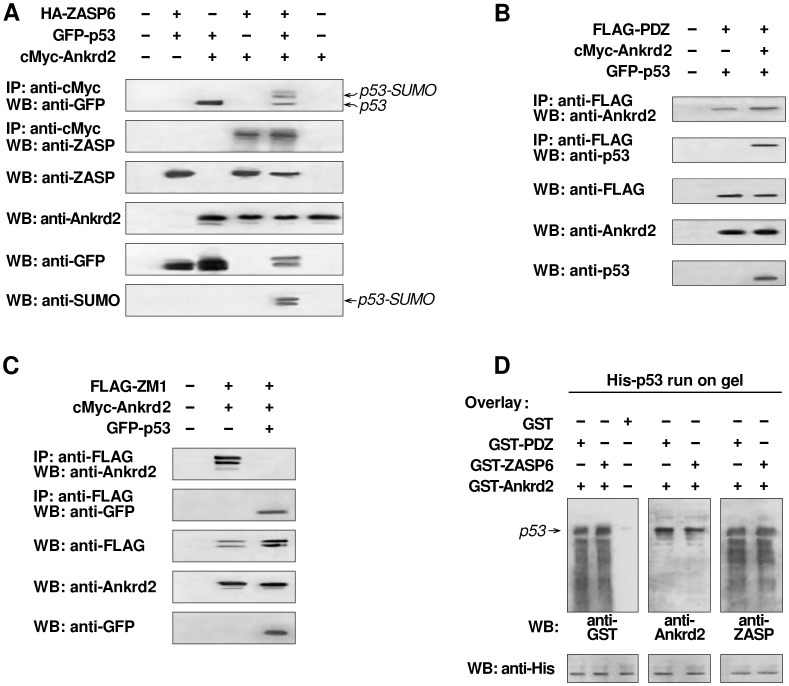
ZASP6, Ankrd2 and p53 are able to form a triple complex.(A) H1299 cells (p53−/−) were transfected with pcDNA3-HA-ZASP6, pcDNA3-p53 and pCMV3B-Ankrd2 as indicated. Transfected cell lysates were used for immunoprecipitation with anti-cMyc antibody. The top two panels represent the immuno-complexes separated by SDS-PAGE and blotted either with anti-GFP conjugated with HRP or anti-ZASP antibodies. Third, fourth and fifth panels represent Western blots of the extracts of transfected cells probed with anti-ZASP, anti-Ankrd2 and anti-GFP antibodies. The membrane where p53 was detected with anti-GFP antibody was stripped and reprobed with a mixture of anti SUMO-1 and anti-SUMO-2/3 antibodies (bottom panel). B) Co-IPs performed using lysates from H1299 cells transfected with pCMV2B-PDZ, pCMV3B-Ankrd2 and pEGFP-p53 as indicated. After immunoprecipitation with an anti-FLAG monoclonal antibody, SDS-PAGE and blotting, the membranes were probed with anti-Ankrd2 (first panel) or anti-p53 (second panel) antibodies. As controls, cell lysates were probed with anti-FLAG, anti-Ankrd2 and anti-p53 antibodies (respectively, third, fourth and fifth panels). C)
In vivo interaction between ZM1, Ankrd2 and p53 was tested by co-immunoprecipitation of Ankrd2 and p53 with immunoprecipitated FLAG-ZM1 from lysates of the transfected H1299 cells using anti-FLAG antibody. Immuno-complexes were separated by SDS-PAGE, blotted and then probed with anti-Ankrd2 (first panel) and anti-GFP antibody conjugated with HPR (second panel). Expression levels of tested proteins were evaluated by Western blot, with anti-FLAG, anti-Ankrd2 and anti-GFP antibodies (respectively, third, fourth and fifth panel). D) GST overlay assay was performed by separating 4 μg of His-p53 by SDS-PAGE and blotting onto membranes. Strips were incubated with the same amounts (4 μg) of GST-PDZ, GST-Ankrd2, GST-ZASP6 and GST alone as indicated and probed in parallel with anti-GST (left panel), anti-Ankrd2 (middle panel) and anti-ZASP (right panel). The lower panel shows a Western blot of the cell lysates probed with an anti-Histidine monoclonal antibody to ensure that equal amounts of His-p53 recombinant protein was used.